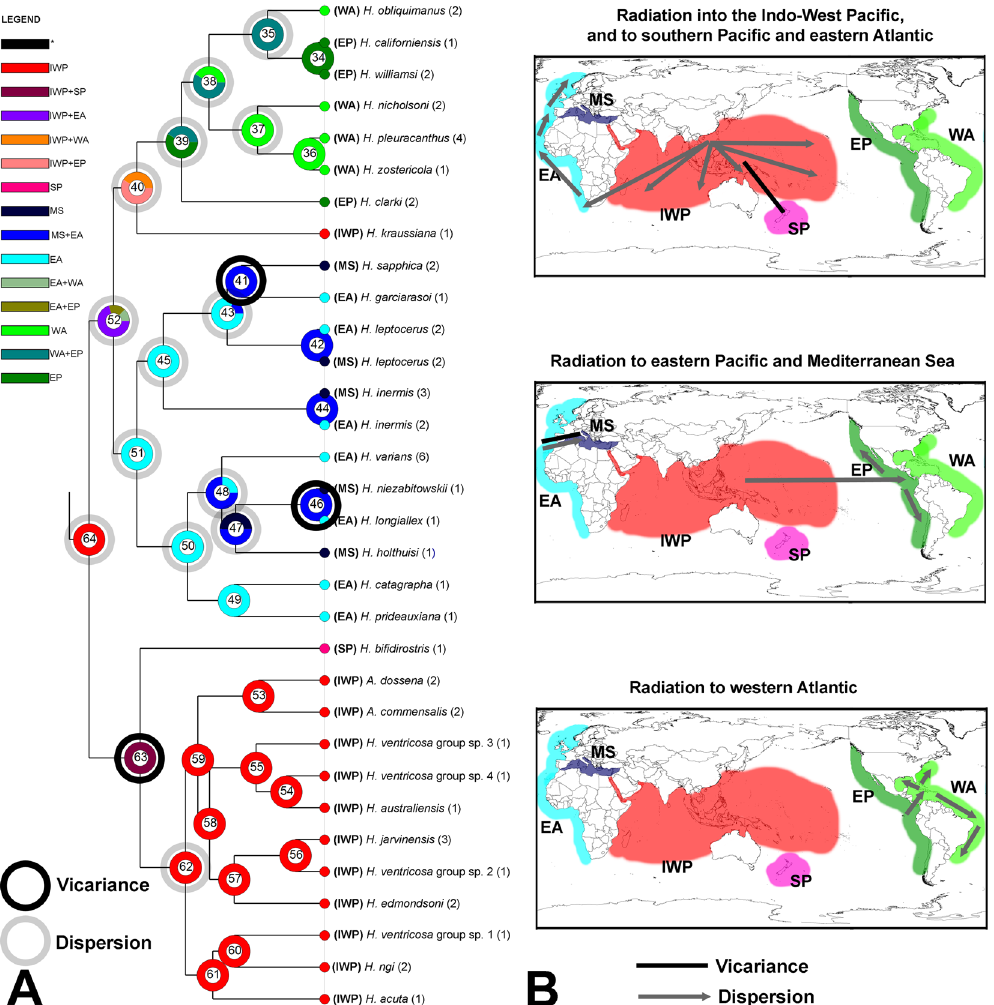
combined 16S, COI, 18S and H3 dataset; colour key to possible ancestral ranges at different nodes; black with an asterisk represents other ancestral ranges. The numbers between parentheses correspond to the numbers of specimens. Outgroups have been excluded from the phylogeny. ( B ) Maps showing the possible geographic history of the genus. Biogeographical regions as follows: IWP: Indo-West Pacific, SP: southern Pacific, EP: eastern Pacific; WA: western Atlantic; EA: eastern Atlantic; MS: Mediterranean Sea. The maps were built with a template of the software Diva-Gis 7.5 74